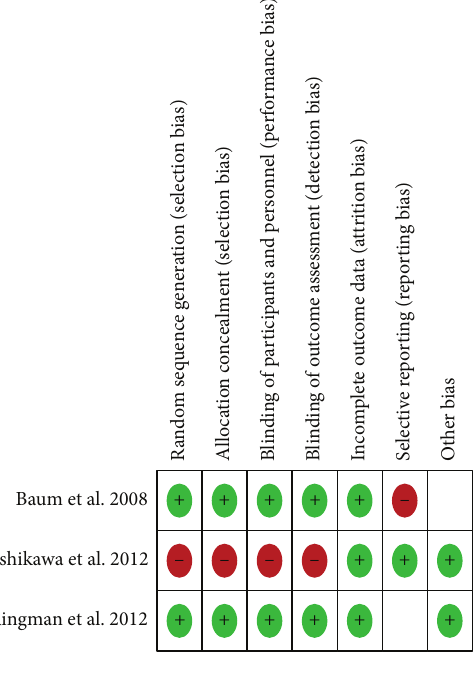
Figure 1: Methodological quality of the included